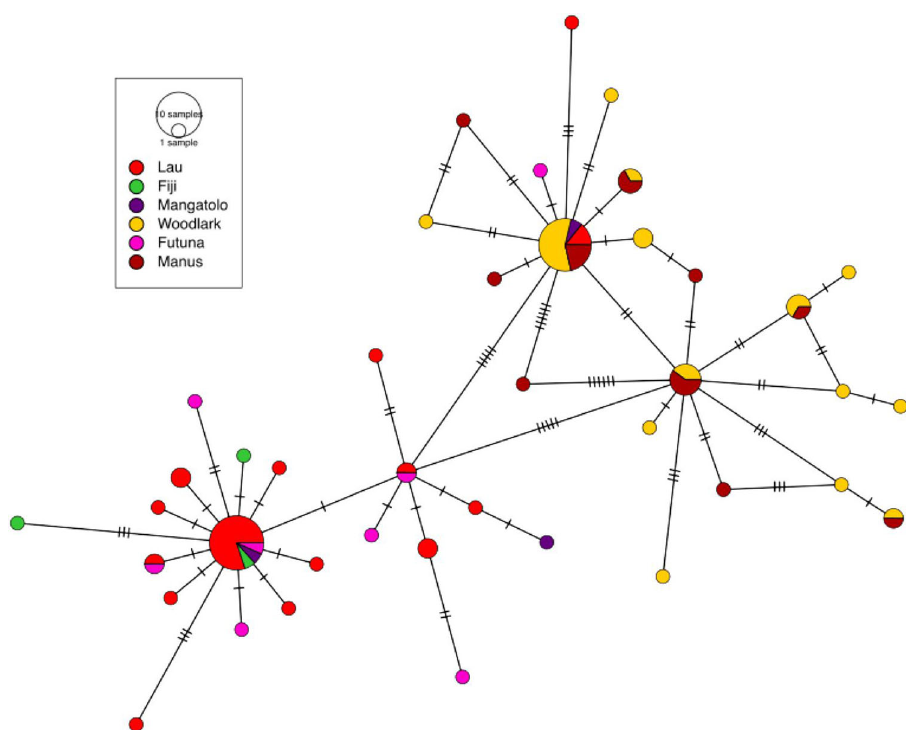
Fig. 8 Haplotype network of the LSVF gastropod Ifremeria . Haplotype network of the Woodlark Ifremeria Cox1 gene (accession numbers: OL448876 - OL448957) with other sequences of geographically referenced individuals using the Median Joining method implemented in the software PopArt 61 . Purple: Woodlark Ridge, pink: Manus basin, Red: Lau basin, Green: North Fiji basin, yellow: